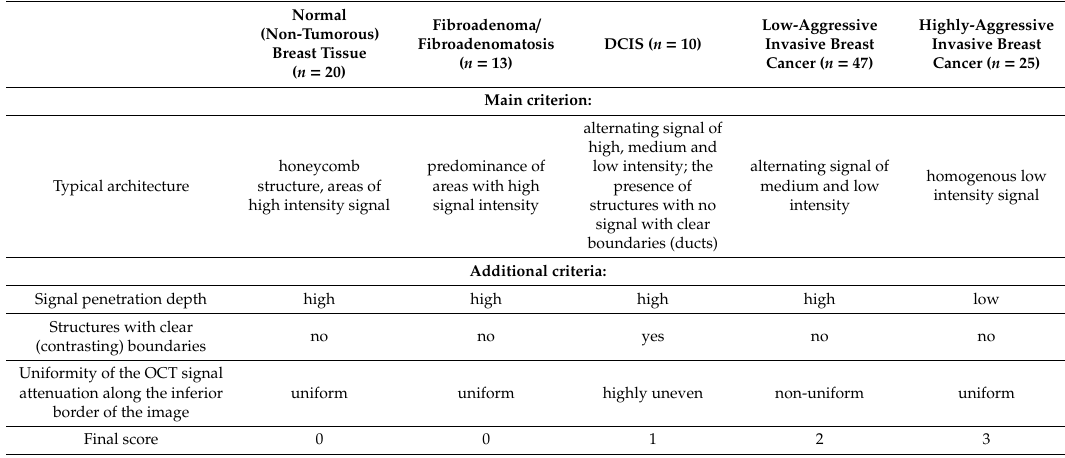
Table 2. Visual assessment criteria of cross-polarization optical coherence tomography (CP-OCT) images for distinguishing between non-tumorous and tumorous breast tissue.